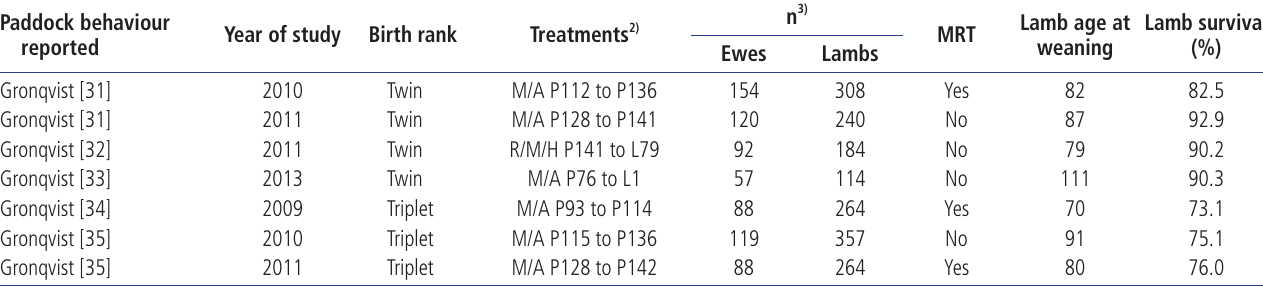
Table 1. Summary of studies from which behaviour data was collected 1)